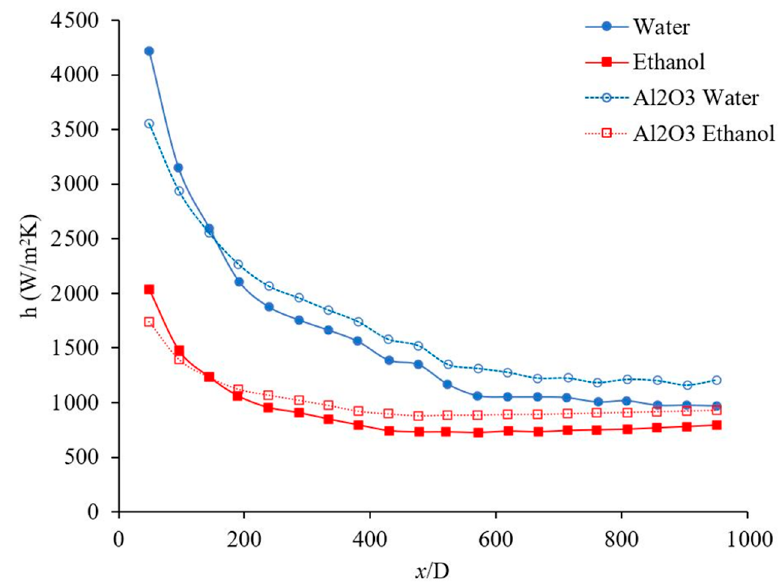
Figure 13. Variation of forced convection heat transfer coefficient as a function of distance for Al 2 O 3 –water and Al 2 O 3 –ethanol nanofluids. Nanofluid concentration was 1 wt %, and the range of Reynolds number inside the microchannel was 150–200. The Al 2 O 3 nanoparticles were commercial.